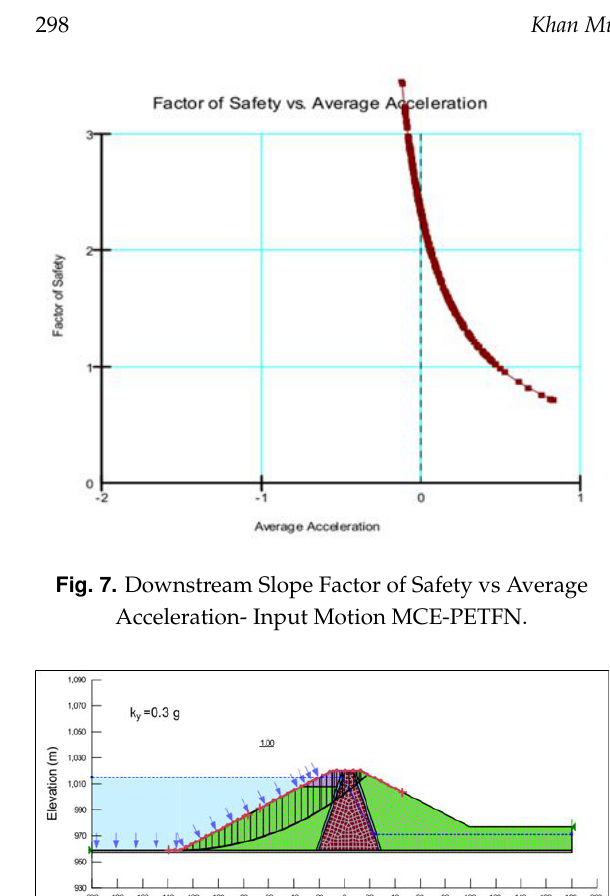
of Newmark Method.